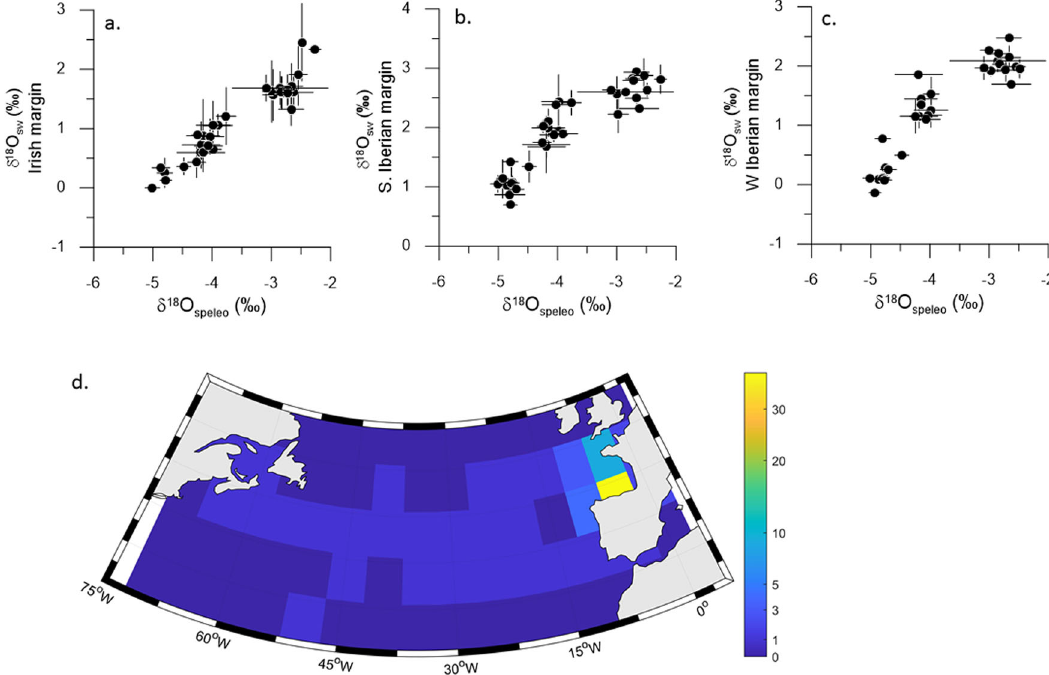
Fig. 2 Prediction of δ 18 O sw from δ 18 O NISA . a – c δ 18 O sw vs δ 18 O NISA in fi xed 500 ky bins over the time interval from 25 to 5 ka BP, on original marine chronologies. Horizontal and vertical lines illustrate plus and minus one standard deviation of the δ 18 O data to illustrate the range of variation within each age bin. Results show δ 18 O sw from the a) Irish margin 16,32 , r 2 = 0.91. b W. Iberian margin 18 , r 2 = 0.85. c S. Iberian margin 17 r 2 = 0.85. d Proportion (as %) of oceanic moisture recharge events originating in each 5° × 5°grid over the ocean, for precipitation events 2015 – 2016 near the cave location, as described in Methods. For regressions, all p -values are < 0.001; full data in Supplementary Table